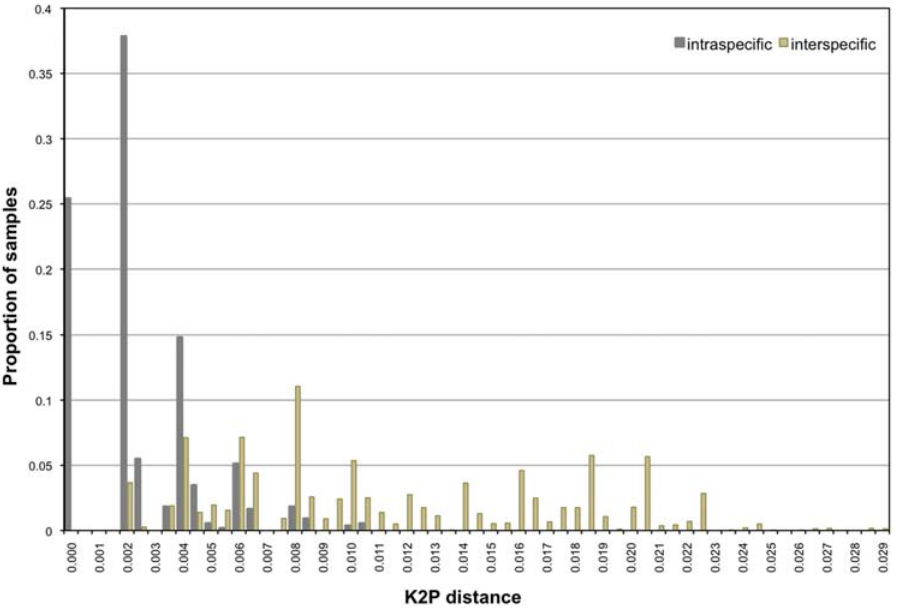
Figure 2. Cumulative intraspecific and interspecific K2P distances for 87 reference sequences. The maximum intraspecific distance was 0.01038 while the minimum interspecific distance was 0.00153.